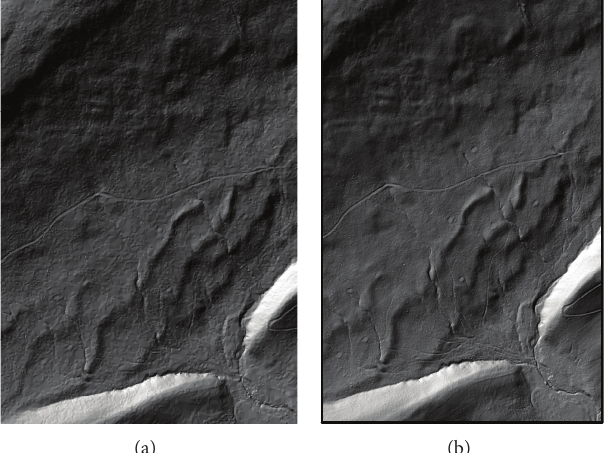
Figure 3: USDA-NRCS SSURGO mapping units for the Leading Ridge Watershed with transect and plot locations.